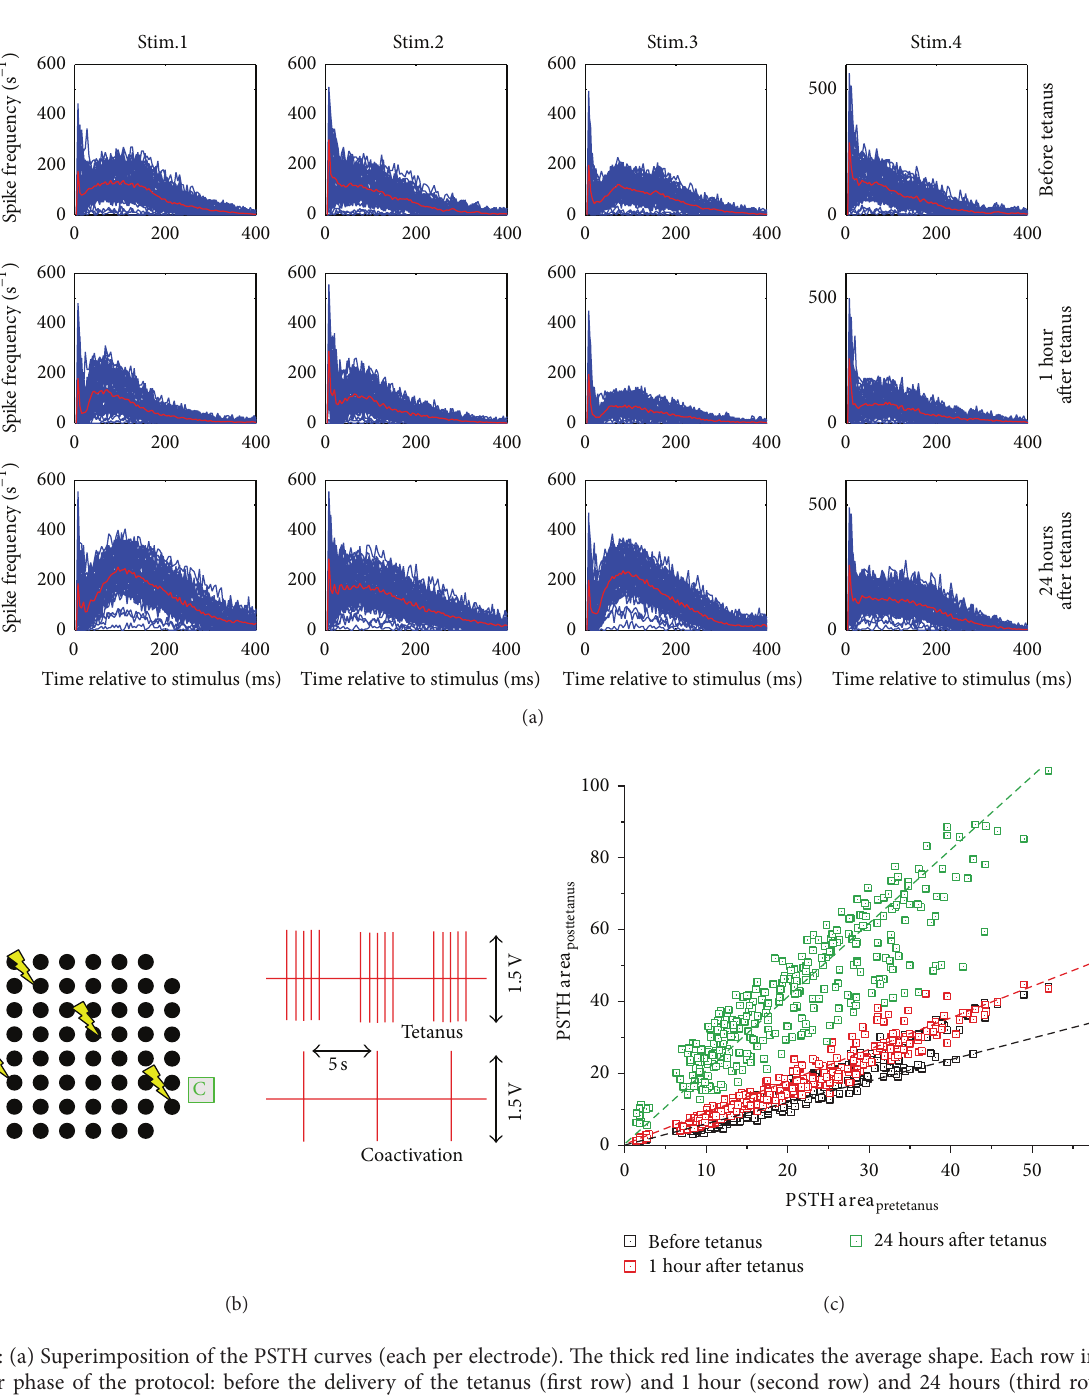
Figure 4: (a) Superimposition of the PSTH curves (each per electrode). The thick red line indicates the average shape. Each row indicates a peculiar phase of the protocol: before the delivery of the tetanus (first row) and 1 hour (second row) and 24 hours (third row) after delivery of the tetanus. Each column indicates a different stimulation site. (b) Sketch of the tetanic protocol described in [20]. Each black dot represents a microelectrode. The yellow arrows indicate where the stimuli are delivered. The tetanic protocol consists of a high frequency tetanic stimulation coupled to a low-frequency (in-phase) stimulation. (c) Scatter plot of the PSTH area for each active electrode. Each point represents an active channel with a certain PSTH area during three phases of the protocol: before the delivery of the tetanus (black squares) and 1 hour (red squares) and 24 hours (green squares) after delivery of the tetanus. The dashed lines represent the linear fitting of the three scatter